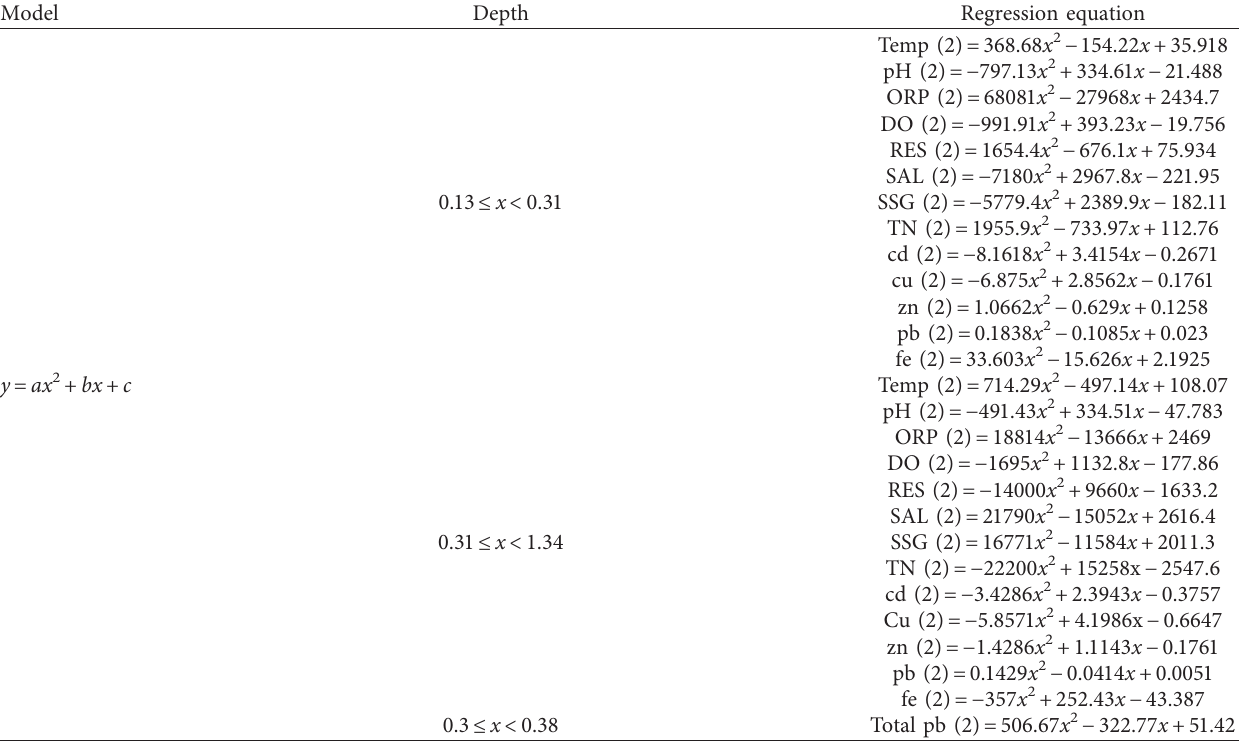
Table 2: Regression model polynomial of the second degree.